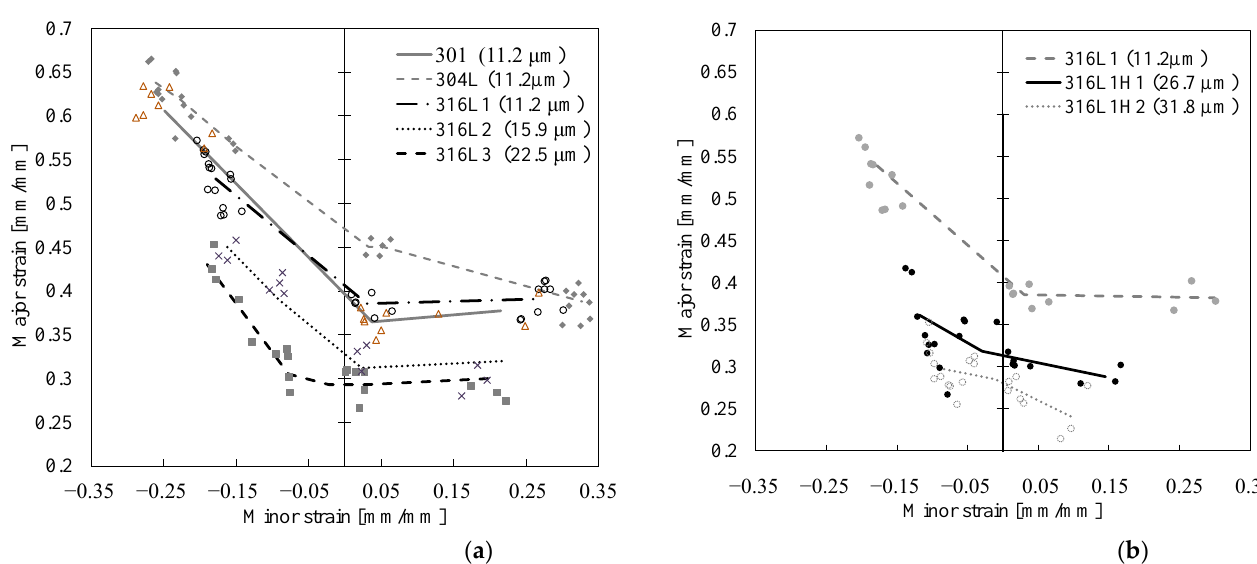
Figure 11. Forming Limit Diagrams (FLDs) of ( a ) commercial alloys and ( b ) 316L1 in the as received and the two heat treated conditions.